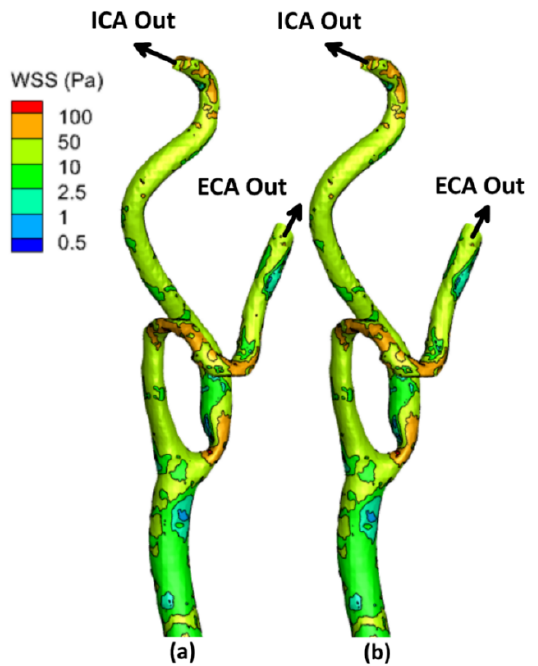
Figure 5. WSS contours for stenotic ICA (model B) of the CA at the peak systole of the cardiac cycle: ( a ) elastic wall, ( b ) rigid wall.